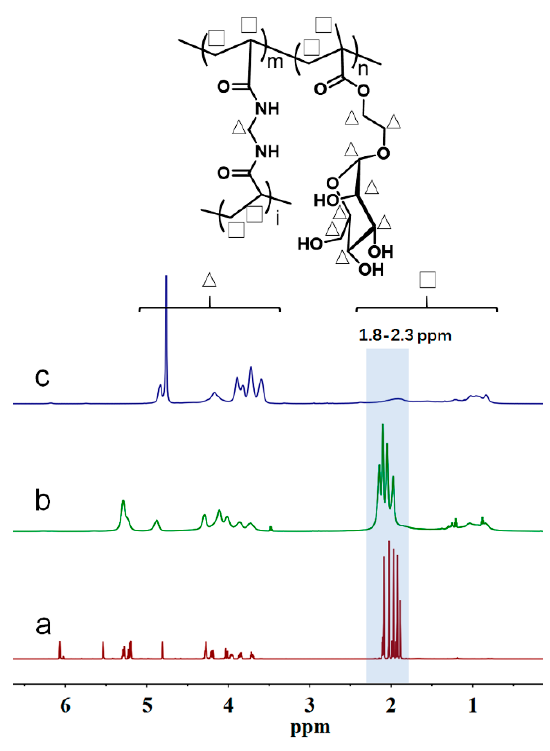
Figure 1. 1 H NMR spectra of: ( a ) AcManEMA in CDCl 3 ; ( b ) HPAcManEMA- co -MBA in CDCl 3 ; and ( c ) HPManEMA- co -MBA in D 2 O.